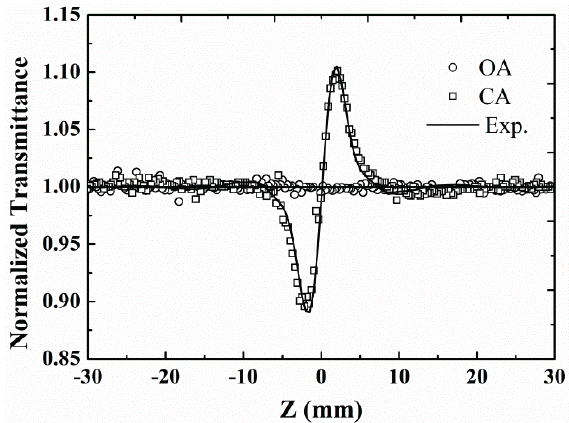
Figure 3. The circles show the normalized transmission without an aperture (open aperture, OA), which is varying as a function of distance along the lens axis. The result reveals that no nonlinear absorption of CH 2 Cl 2 could be observed within the limit of the intensity (1.1 GW/cm 2 ) used in the experiment. However, the closed aperture (CA) result (squares) shows an obvious valley-peak configuration, which indicates a positive nonlinear refraction.